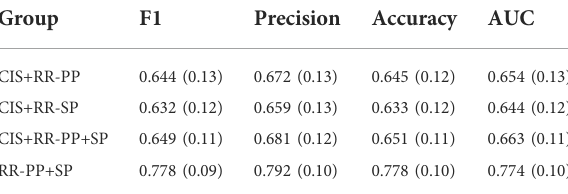
TABLE 7 Ablation study: Mean (st.dev) of the predictive performances of the ensemble model across the ten folds of the cross validation using FSAverage atlas and multiclass binary comparisons.